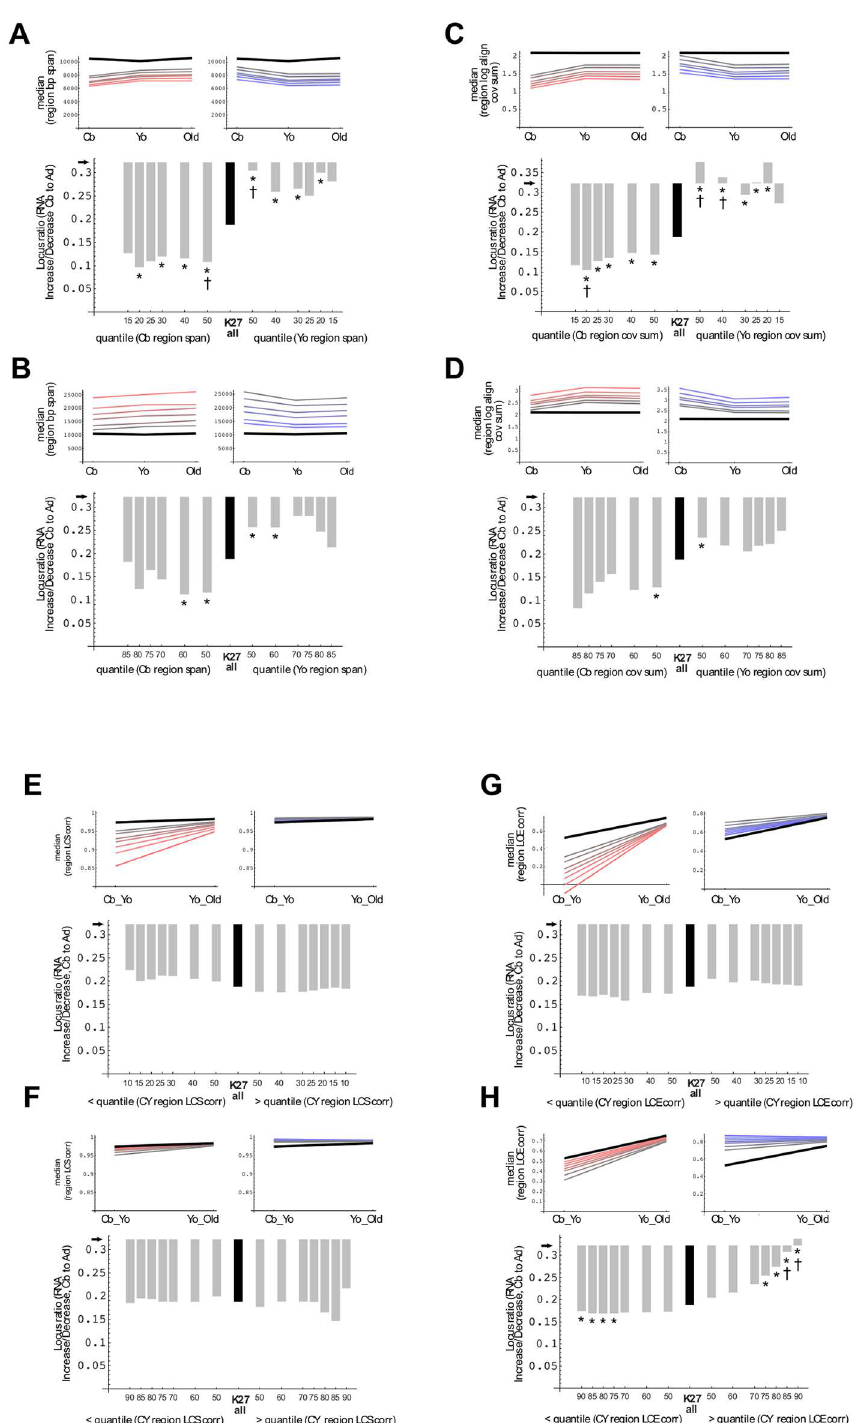
Fig 11. PcG region-linked gene expression change: Conventional vs. alternate parameters. Ratios of significant (FDR < 0.05) up- vs. down-regulated monocyte expression change are plotted, with black arrows indicating ratio for all quantified gene loci and bars depicting deviation. Black bar in each panel shows deviation for all PcG region overlapping loci, whereas for gray bars depict quantile-defined subsets. Plotted in smaller inset panels are total median PcG region values (black line), together with subset median values for the restricted parameter, with shaded colors matching points in the bar graphs. Asterisks denote significant (p < 0.05, Fisher’s test) ratio differences